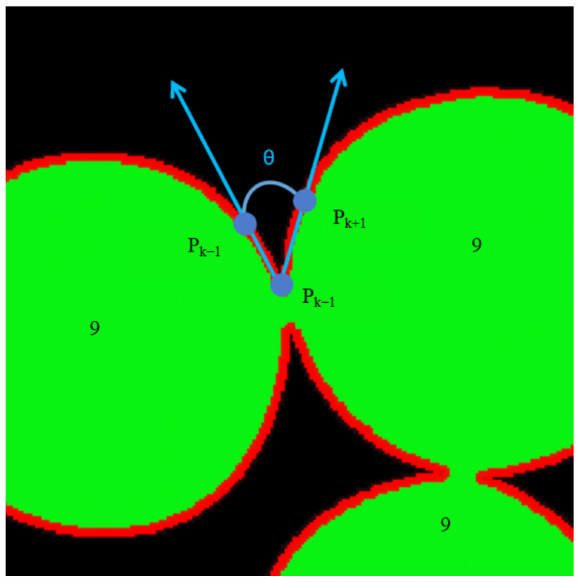
Figure 5. A partial enlargement of the contour of the tangent pearls’